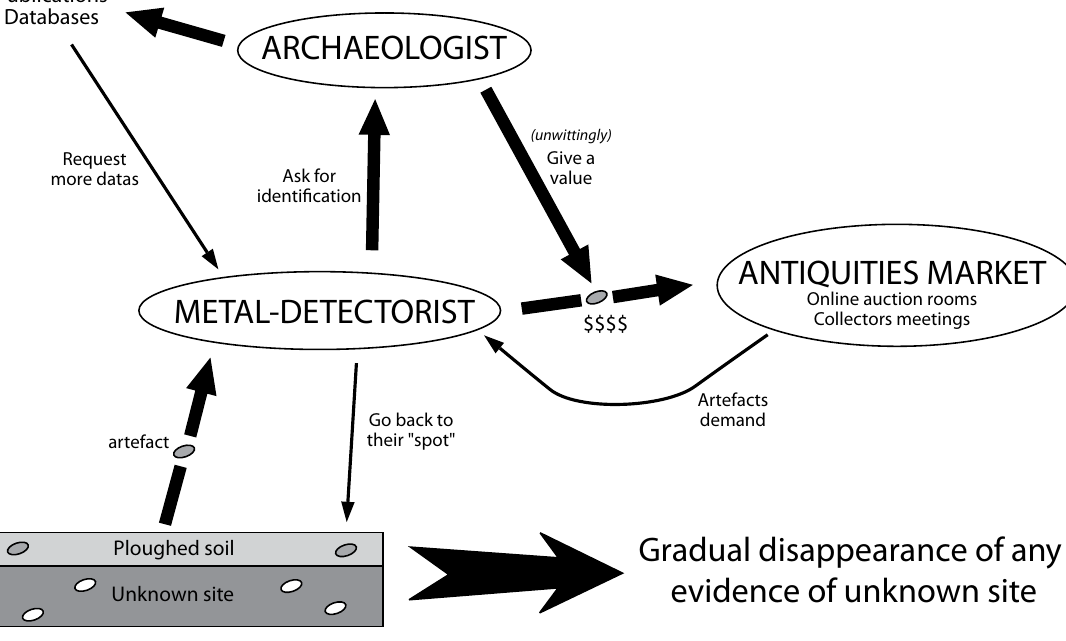
Figure 3: The vicious circle of grey data